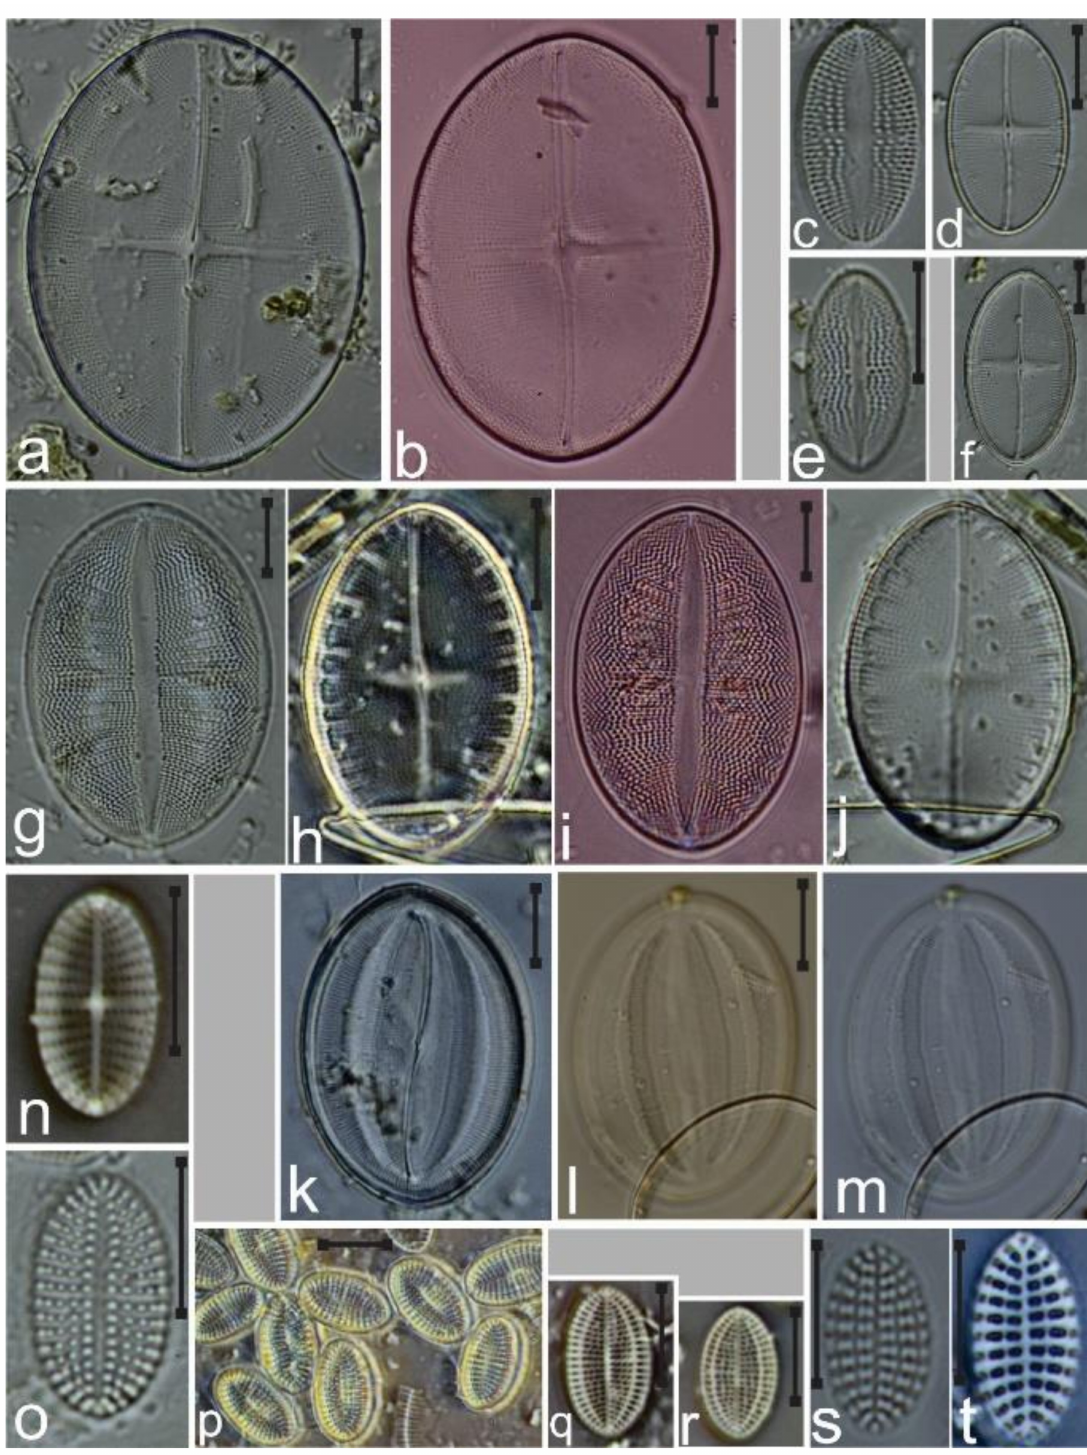
Figure 23. ( a – j ) Cocconeis dirupta raphe and sternum valves at di ff erent focal planes and showing range in size; ( k – m ) C. heteroidea ; ( n – p ) C. scutellum var. parva , images n and o , raphe and sternum valves, respectively; ( q , r ) C. californica ; ( s , t ) Amphicocconeis disculoides . Images q – t sternum valves. Scale bar = 10 µ